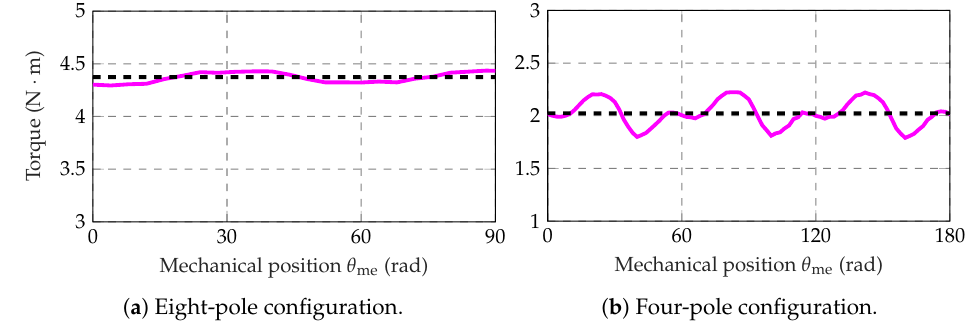
Figure 18. HE-IPM torque ripple with rotor skewing solution.